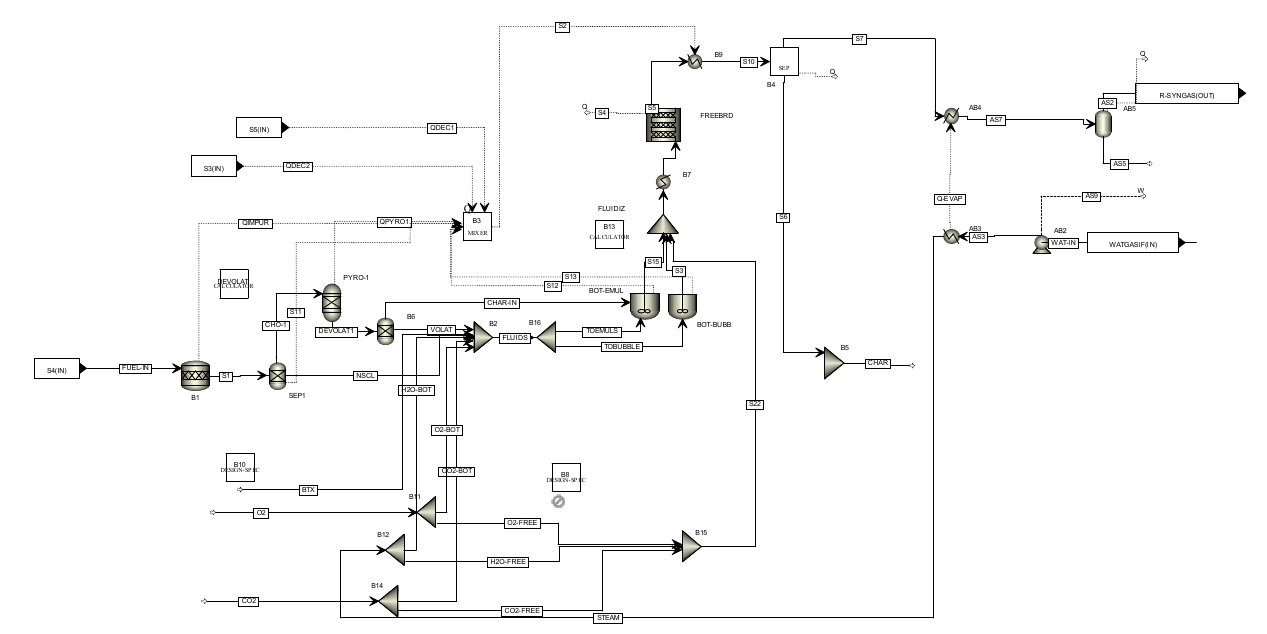
Figure A2. Aspen flowsheet of the HTW gasifier model.